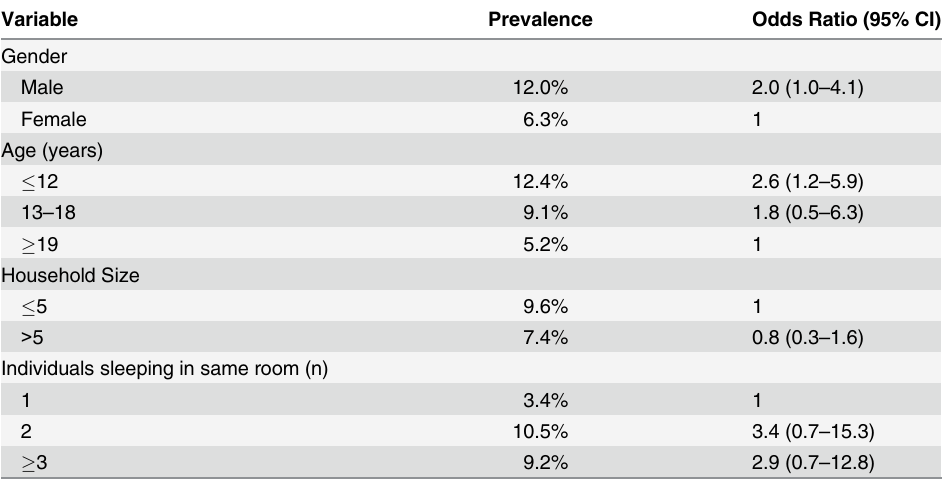
Table 2. Risk factors for